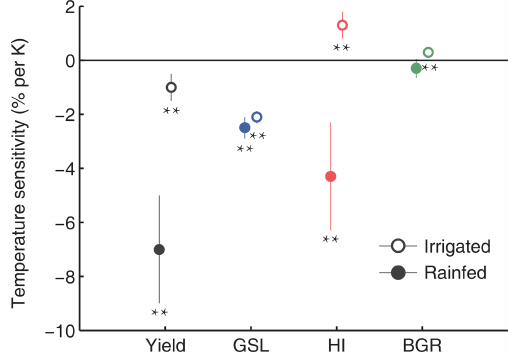
Figure 7. Temperature sensitivity of yield and yield compo- nents (GSL, HI, and BGR) for irrigated and rainfed maize areas. The error bars represent the 95% confidence interval of estimated temperature sensitivity. Double asterisks ( ∗∗ ) indicate a significant estimation of temperature sensitivity with p < 0 . 01, while a single asterisk ( ∗ ) indicates significance with p < 0 .